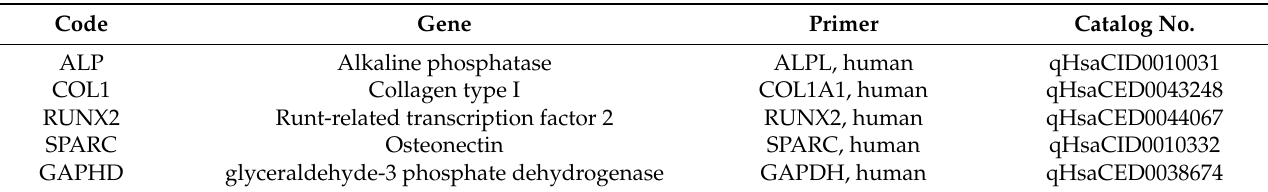
Table 1. Selected primers for gene